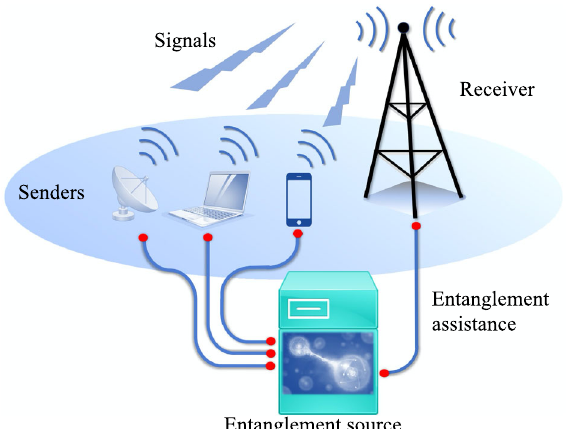
Fig. 1 Conceptual schematic of EA classical communication over a MAC. The entanglement source distributes entangled pairs to each sender and the receiver, potentially via a quantum network. Each sender encodes its own message on its share and sends the signal to the receiver. The receiver decodes the messages of all senders by jointly measuring the received signals and the entanglement- assistance locally stored.